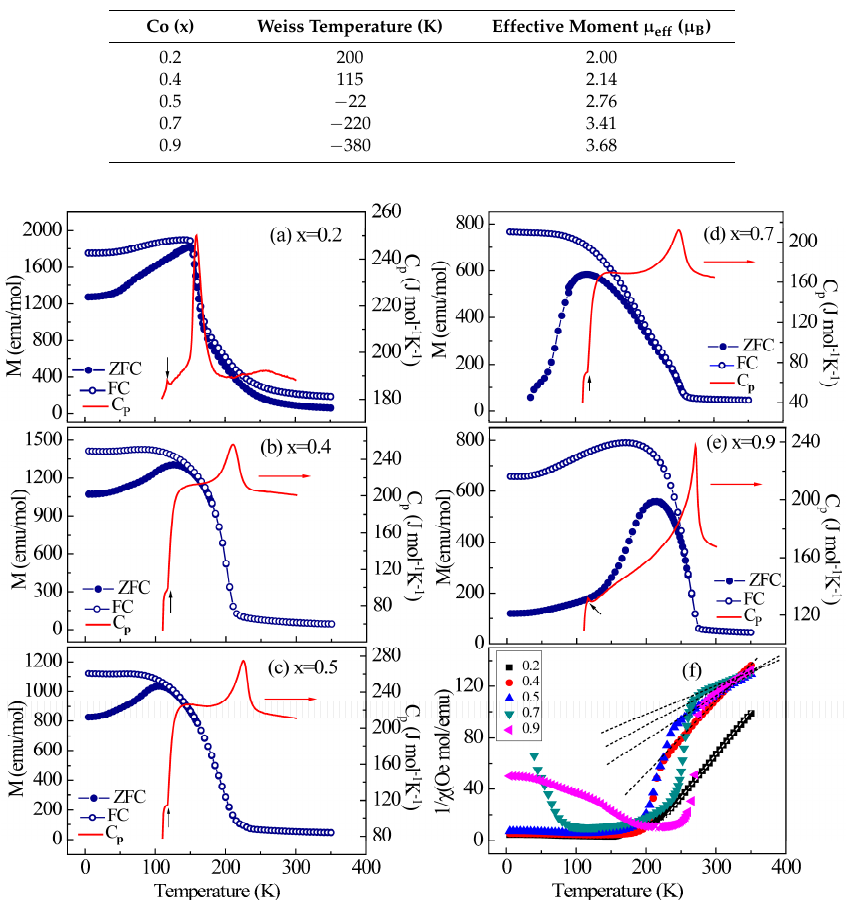
Figure 2. Temperature dependence of the magnetization and specific heat C P for Mn 3 Zn 1 − x Co x N compounds: ( a ) x = 0.2; ( b ) x = 0.4; ( c ) x = 0.5; ( d ) x = 0.7; ( e ) x = 0.9. The small cusp in specific heat curves at 115 K represents the contribution of MnO; ( f ) Temperature dependence of the inverse magnetic susceptibility for Mn 3 Zn 1 − x Co x N. The fitting lines represent the Curie-Weiss